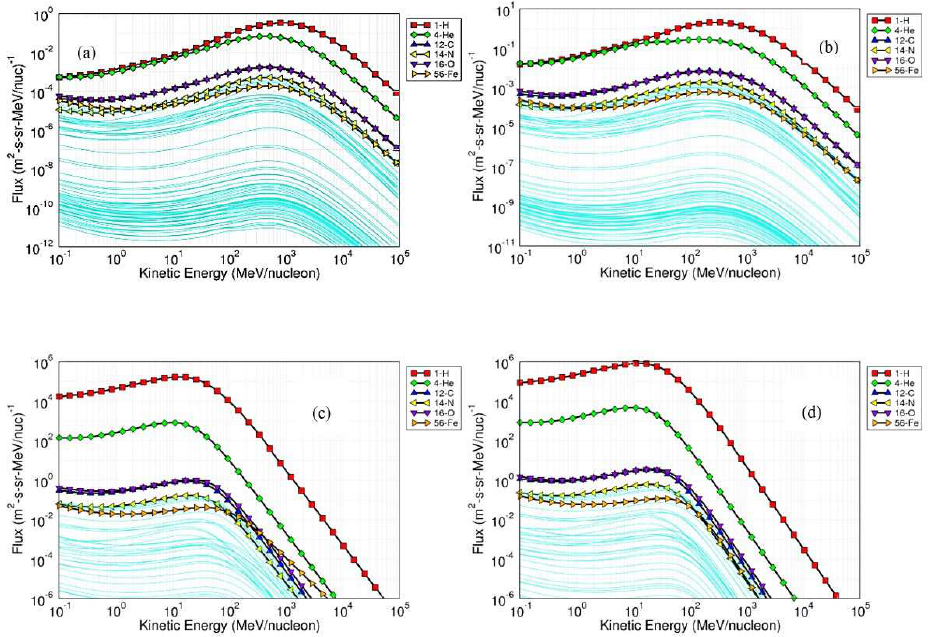
Figure 10. Creme results in GEO: ( a ) cosmic ray min; ( b ) cosmic ray max; ( c ) worst week; and ( d ) worst day.